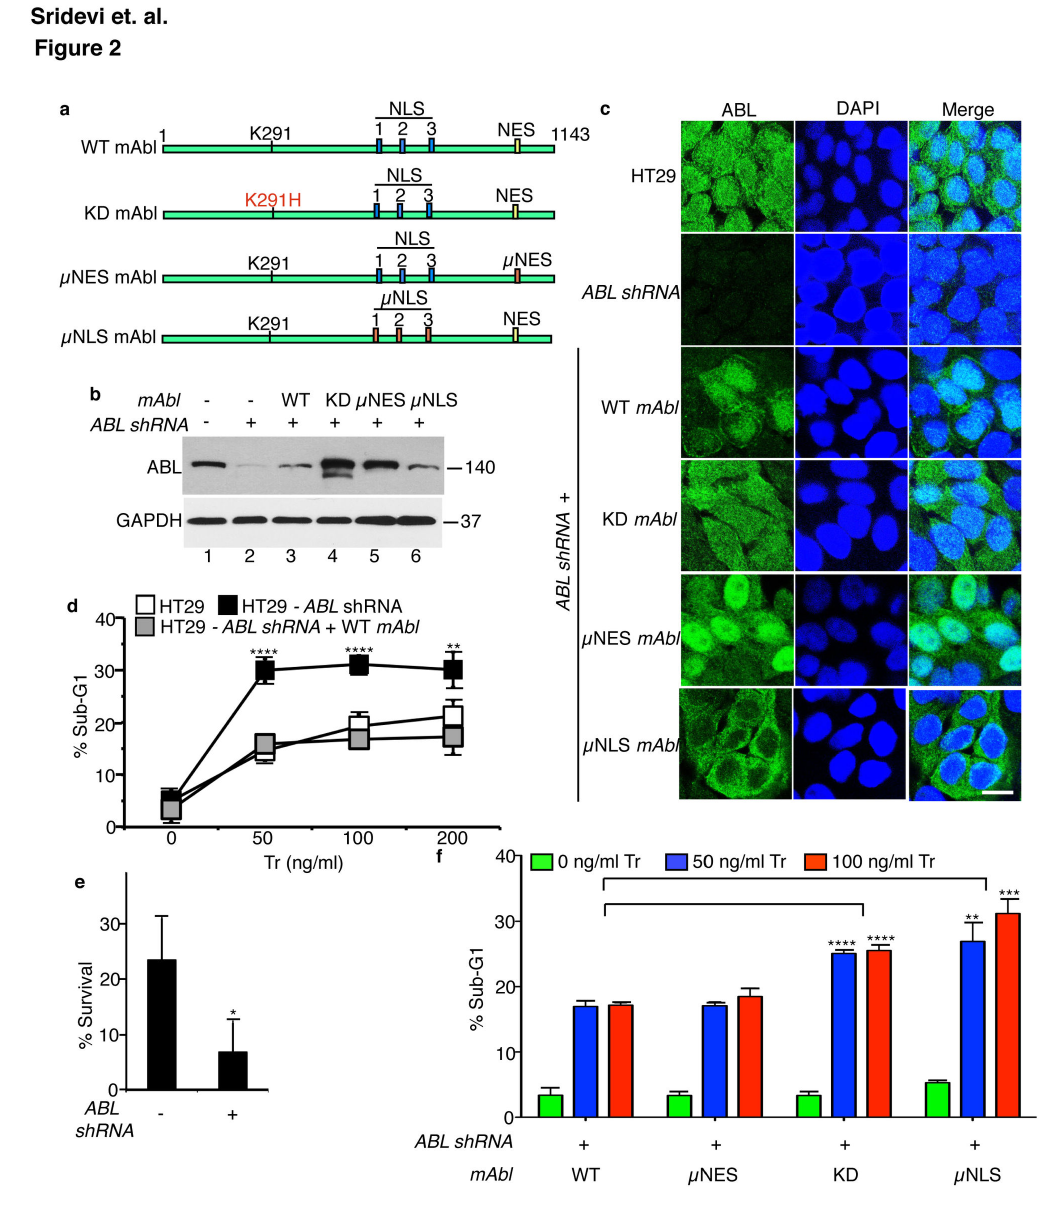
Figure 2. Inhibition of TRAIL-induced apoptosis requires ABL kinase activity and nuclear localization. a. Schematic representation of the Type VI mAbl cDNA constructs used in reconstitution experiments. WT, wild type; KD, kinase defective (K291H); µNLS, nuclear localization signals mutated (11 K/R substitutions with Q); µNES, nuclear export signal mutated (L1064A). b. Levels of endogenous ABL and mAbl proteins in whole cell lysates of the indicated HT29 cells. c. Immunofluorescence staining of the indicated HT29 cells with anti-ABL (green) and DAPI (blue). Scale bar - 20 µm. d. ABL knockdown enhanced, and reconstitution with mAbl, suppressed TRAIL-induced sub-G1. Cells treated with the indicated doses of TRAIL were collected at 16 hr and analyzed for sub-G1 by FACS. Values shown are mean and standard deviation from five independent experiments. **** = p < 0.00005 and ** = p < 0.005. e. ABL knockdown reduced survival. Cells were treated with 100 ng/ml Tr daily for three days, replated in media without Tr for another 3-days and cell survival measured by crystal violet assay (see Materials and Methods). Values shown are mean and standard deviation from three independent experiments each with four repeats. * p = 0.03. f. Inhibition of TRAIL-induced apoptosis requires mAbl kinase activity and nuclear import. Cells were treated with the indicated doses of Tr as in (d). Values shown are mean and standard deviations from 5 independent experiments. ** = p < 0.005, *** = p < 0.0005, **** = p < 0.00005. doi: 10.1371/journal.pone.0077495.g002 PLOS ONE |